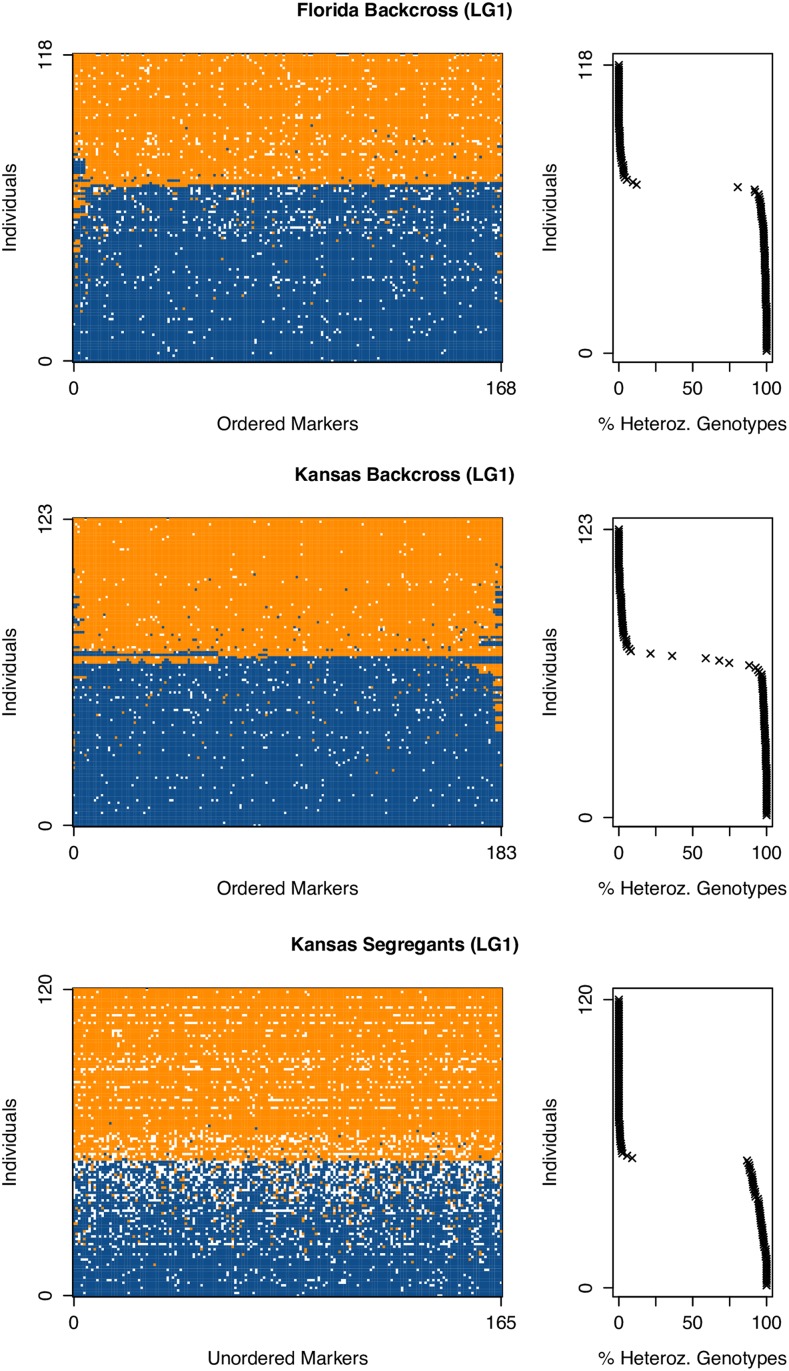
Limited numbers of crossovers in backcross populations. The panels on the left show genotypes for individuals (rows) and markers (columns) for each mapping population for linkage group 1 (LG1). Heterozygous genotypes (FL/KS) are shown in blue, homozygous genotypes (either FL/FL or FL/KS) are shown in orange, and no-calls are shown in white. Only a subset of individuals and markers are presented in the figure to minimize the number of no-call genotypes shown. In the recombinant, backcross populations, with few exceptions (generally near the ends of the linkage groups), the majority of individuals exhibit the same genotype call for the entire chromosome. This is particular clear in the panels on the right, which show the fraction of called genotypes in each individual that are heterozygous.